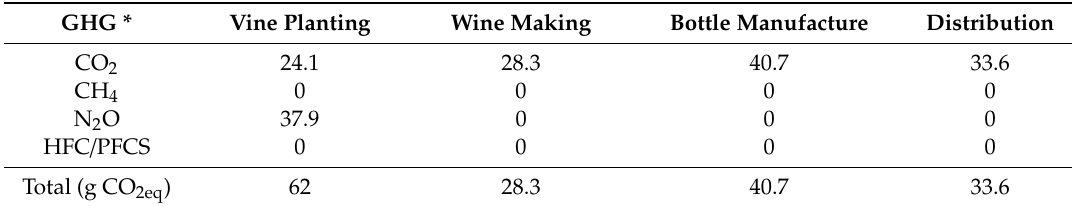
Table 3. Data inventory for solid waste disposal (g) for various stages of wine making per functional unit *. Table 2. Data inventory for greenhouse gas emissions (g CO 2eq. ) for various stages of wine making per functional unit * . Constituent GHG